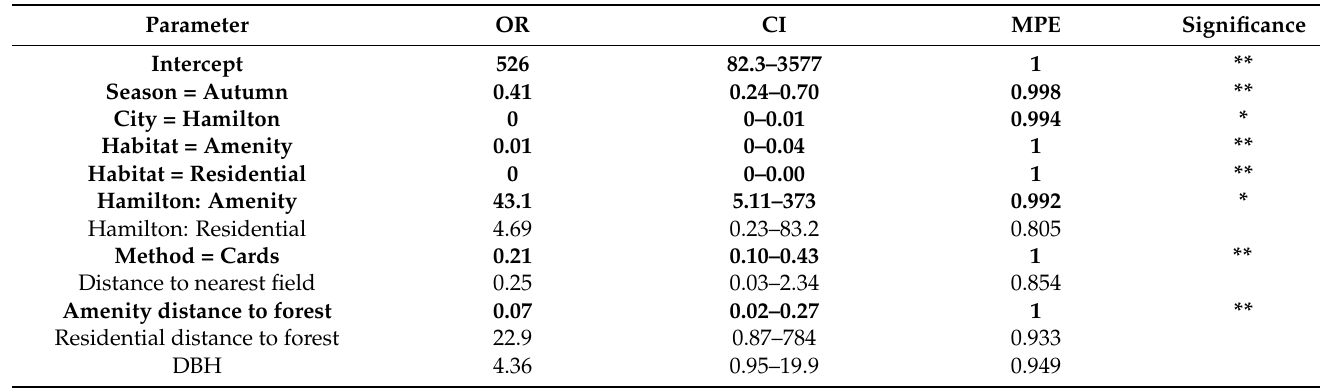
Table 5. Possums: summary statistics for coefficients of the parameters in the main possum model.